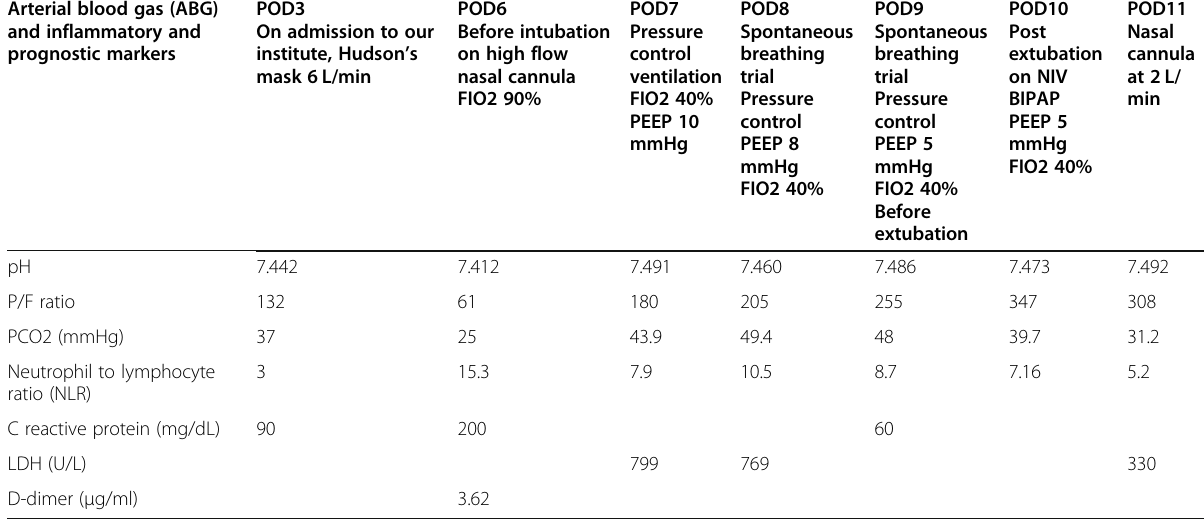
Table 1 Serial arterial blood gas analysis and trend of prognostic markers Arterial blood gas (ABG) and inflammatory and prognostic markers